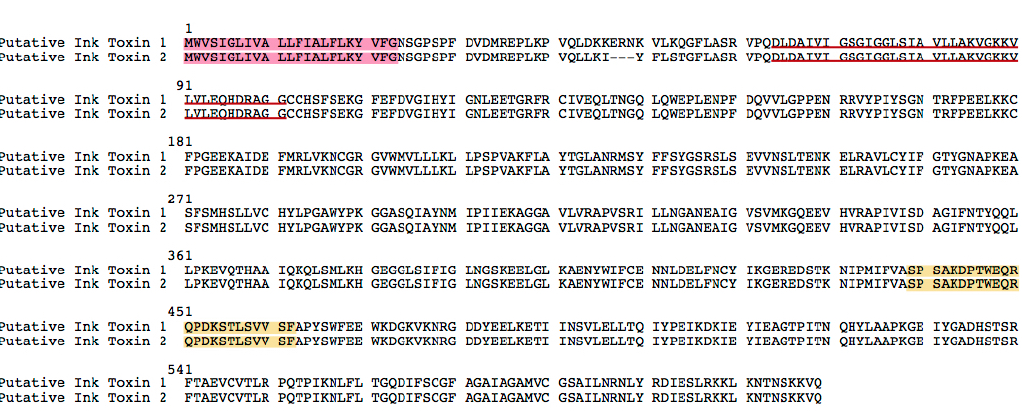
Figure 6. The putative Ink toxin sequences from Chinese yellow catfish. Sequences in the red background are signal peptides. Peptides in the yellow background are verified by LC-MS/MS analysis. The red underlined regions are the FAD domains.